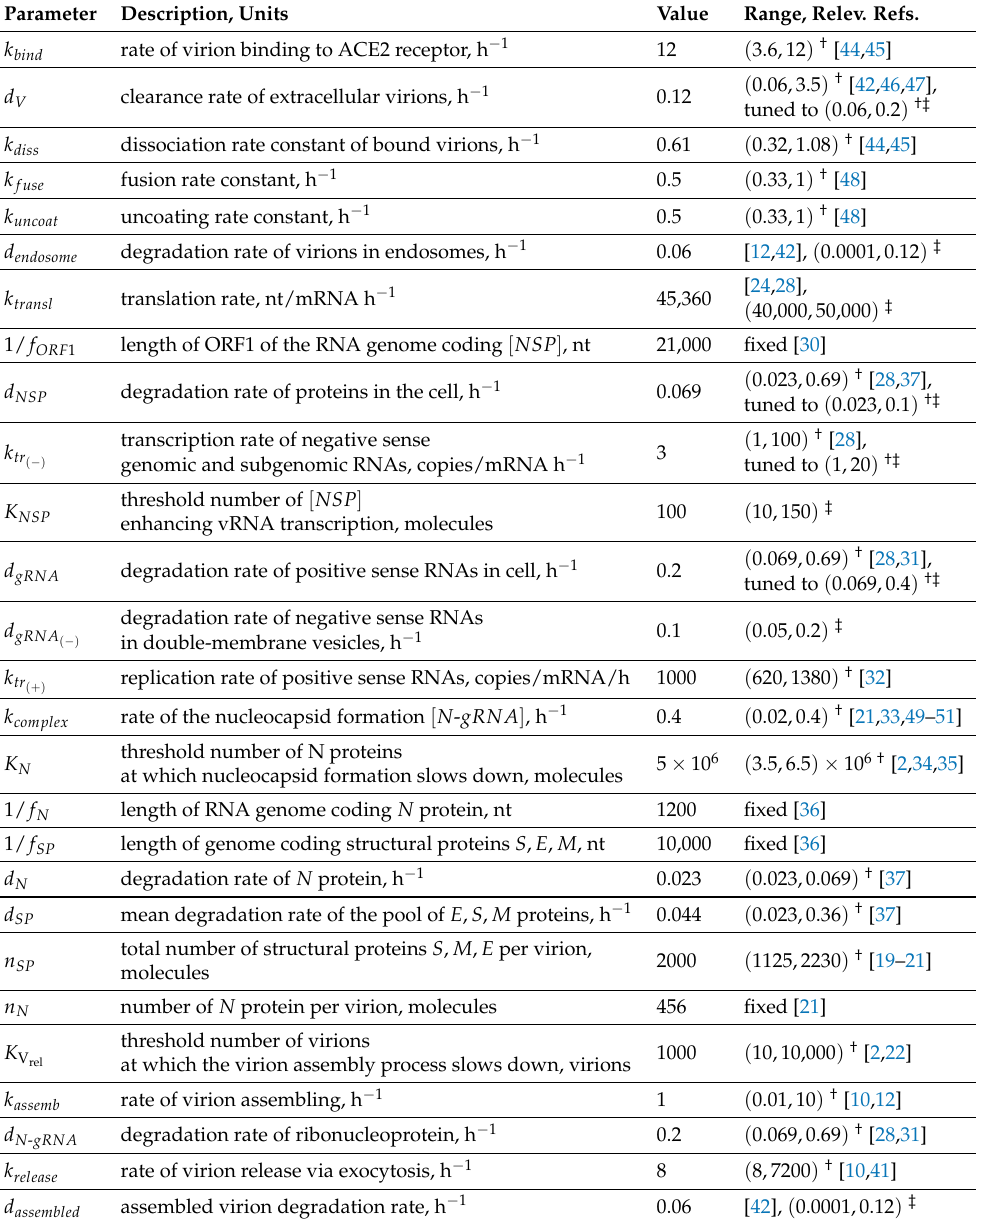
Table 2. Estimates of the calibrated model parameters. The parameter range categories are labelled as follows: ranges based on the analysis of (†) literature, (‡) uncertainty quantification, (†‡) both. Parameter Description, Units Value Range, Relev.